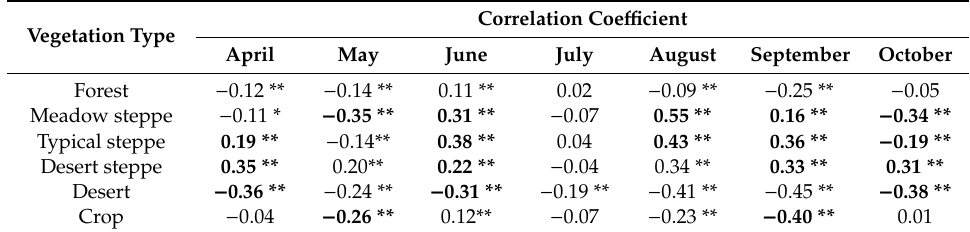
Table 4. Correlations between the CVs of monthly NDVI and those of the precipitation in the previous month for di ff erent biomes in Inner Mongolia from 1982 to 2015.